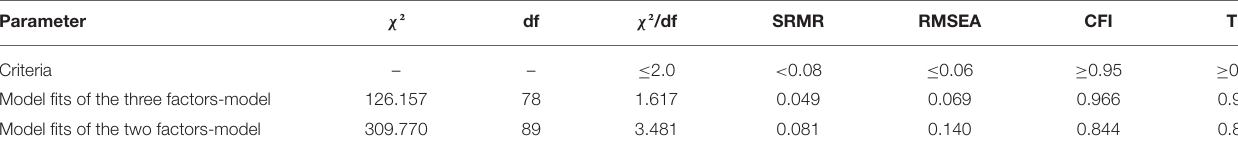
TABLE 3 | Comparing Model fits between three factor-model and two factors-model through confirmatory factor